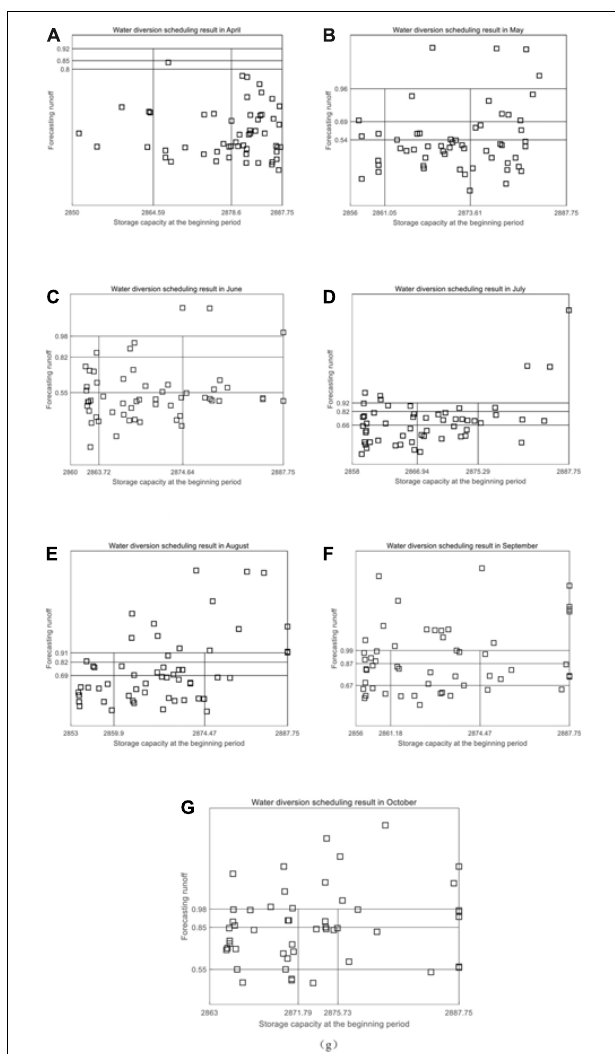
FIGURE 12 | Water diversion scheduling results between April and October. Each square point represents the scheduling status at the beginning of the scheduling period, so that the corresponding mode can be selected. (A–G) Water diversion scheduling results in April, May, June, July, August, September, and October, which have been displayed in the upper part of each